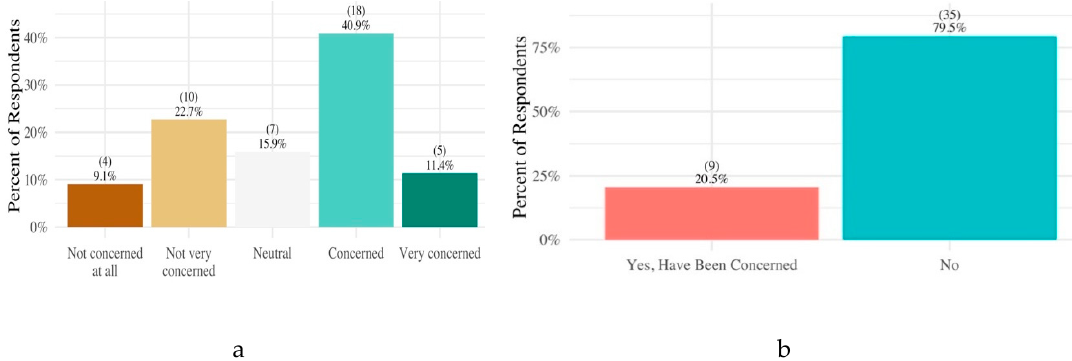
Figure 2. Level of concern of participants with potential health e ff ects of hmm contaminants ( a ) and produce grown in their gardens ( b ).